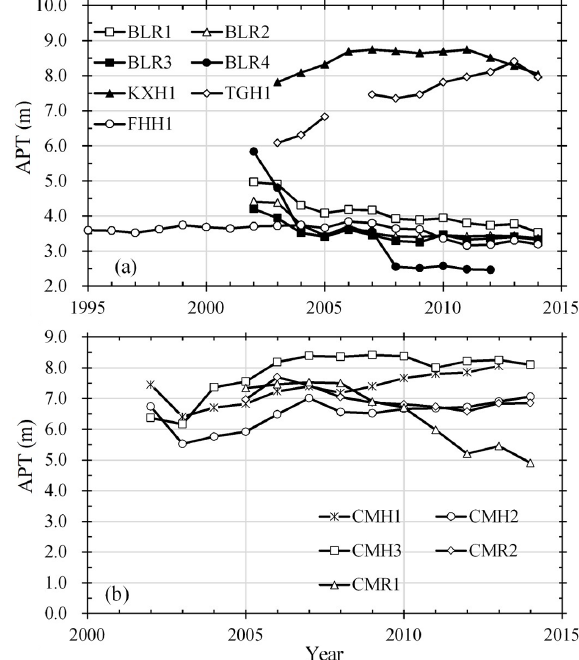
Figure 3. Artificial permafrost table (APT) beneath embankment in alpine meadow (a) and alpine steppe (b)